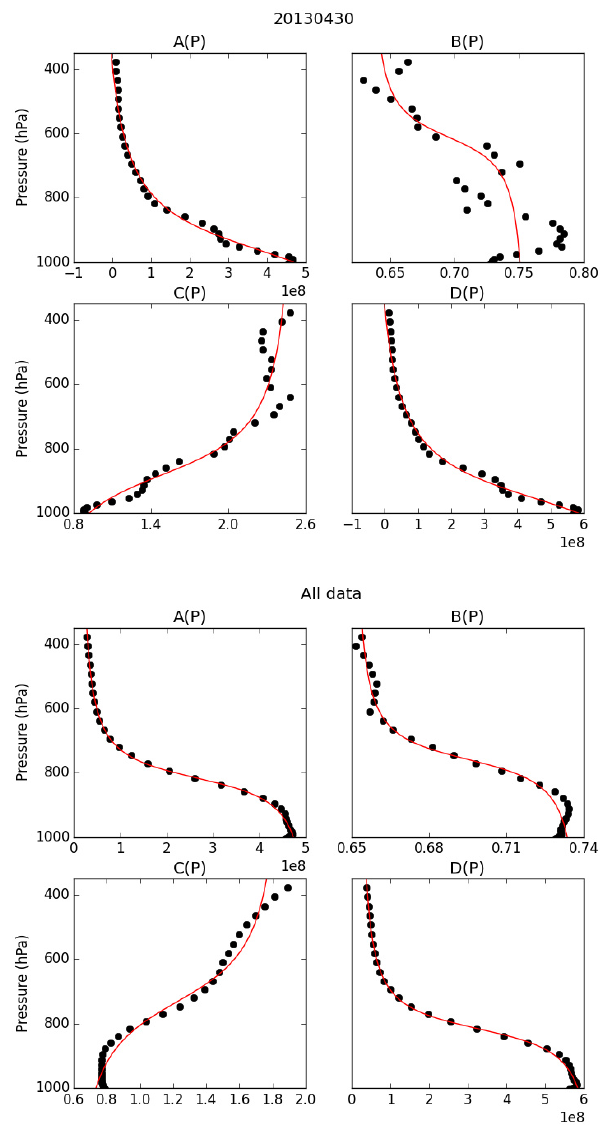
Figure 7. Parameters A , B , C , and D as a function of pressure for 30 April 2013 (top) and all data (bottom). Black circles represent the model data, red lines are the best fit